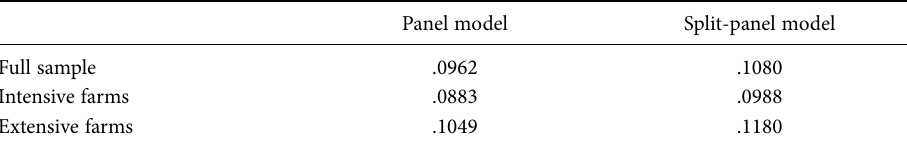
Table 8. Average difference between the frontier output of the two technologies.